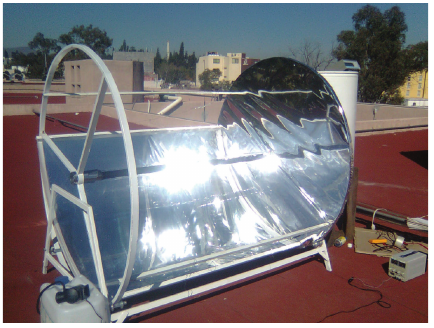
Figure 3: Northern flat secondary mirror.